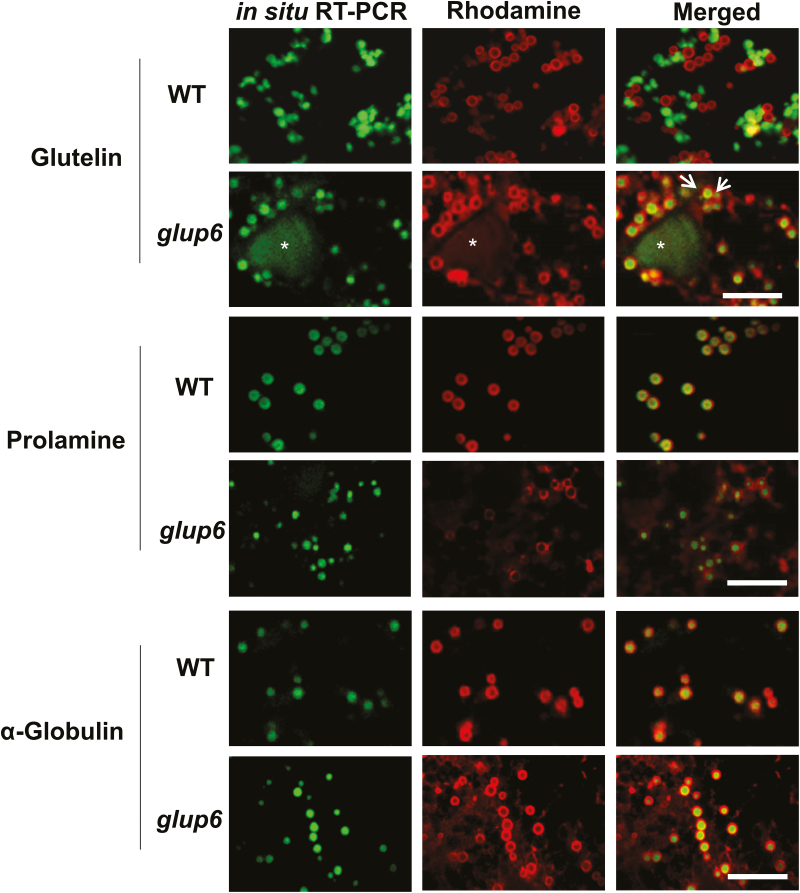
Localization of glutelin, prolamine, and α-globulin RNAs in wild-type (WT, TC65) and glup6 mutant lines. In glup6, glutelin (LOC_Os01g55690) RNAs are mislocalized to the protein body-ER (PB-ER; ringlet structures labeled red by Rhodamine) and paramural bodies (PMBs; indicated with asterisks), while prolamine (LOC_ Os07g10570) and α-globulin (LOC_Os05g41790) RNAs are distributed to their normal locations on the PB-ER. It should be noted that in many instances RNAs localized to PB-ER, such as α-globulin RNAs (bottom panels), are observed as deposits instead of being distributed to the periphery of the prolamine protein body This is an artefact probably caused by the high temperature used in the in situ RT-PCR procedure, which apparently disrupts the integrity of the ER membrane and causes it to condense as a particle The intense Rhodamine staining of the PB-ER compared to the cisternal-ER is also contributed by its binding to the surface of the hydrophobic prolamine inclusion granule. Scale bars are 5 μm.